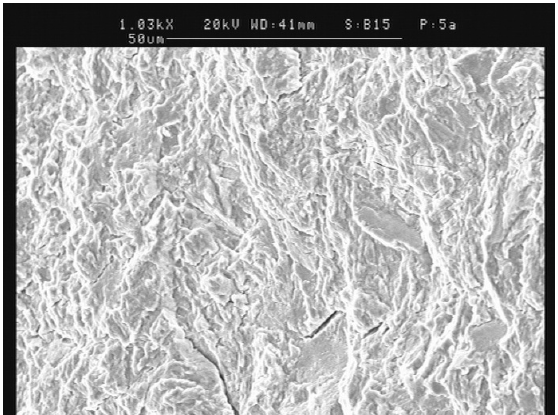
Figura 9: Analisi microfrattografica (SEM) della zona di materiale corrispondente alla elevata dispersione di risultati evidenziata in Fig. 7. (   22 MPa m K Figura 9: SEM investigation of the scattered data (Fig. 7) fracture zone of the sample material (   22 MPa m K